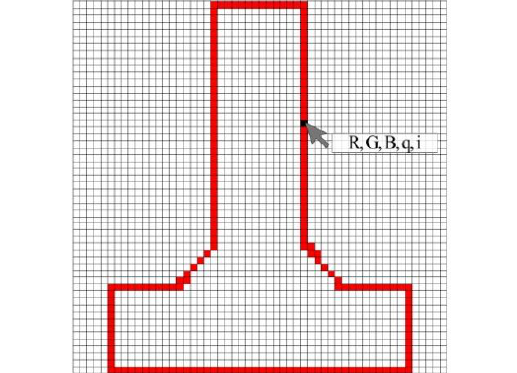
Figure 5. Discretized cross section projected from the point cloud on the solid